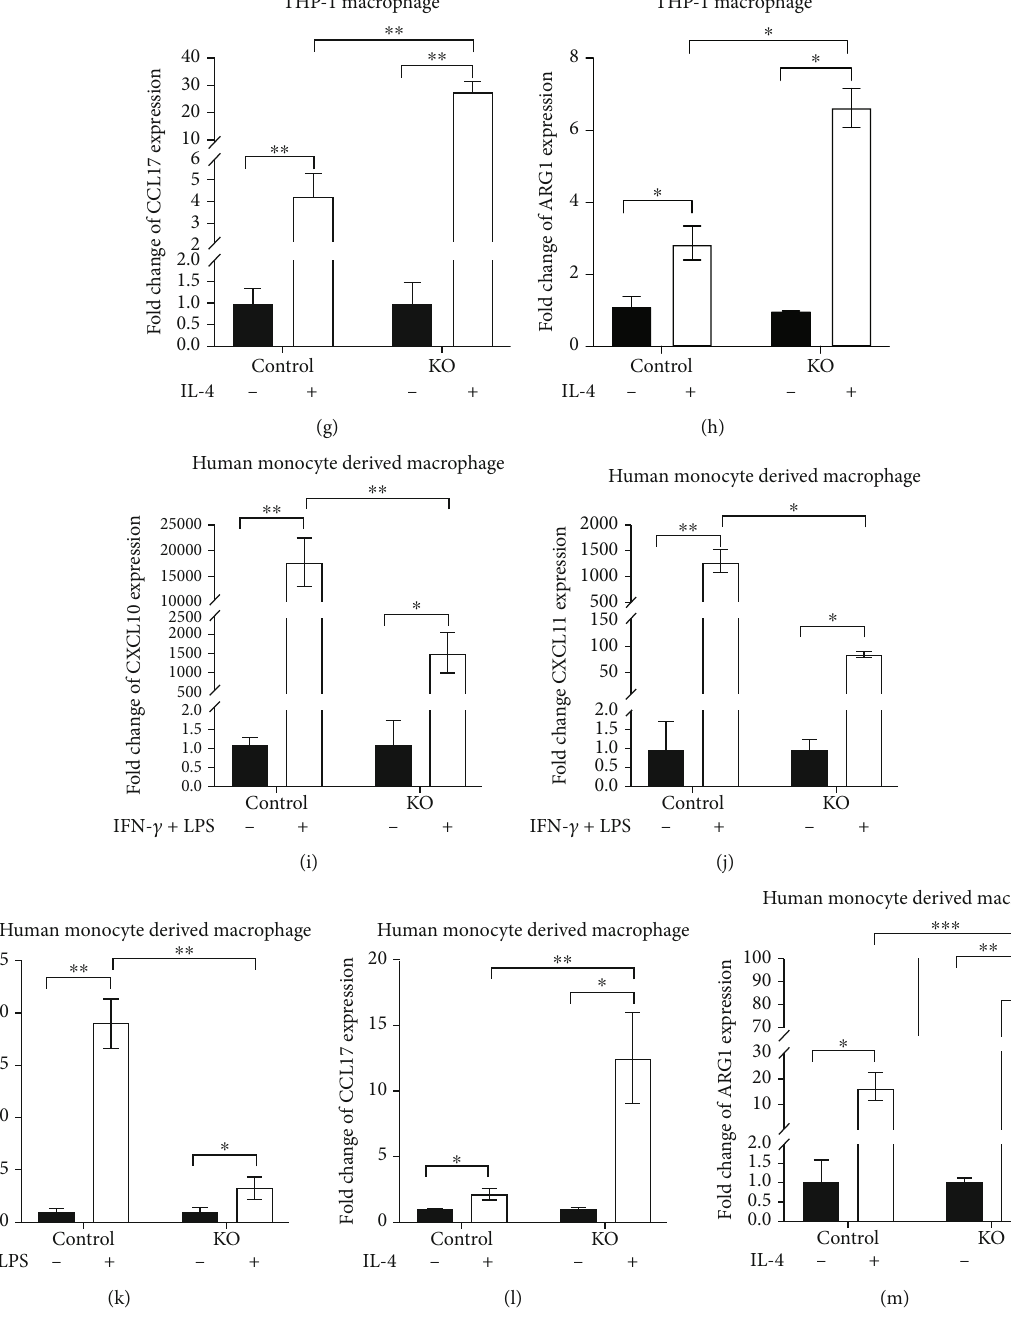
Figure 4: Knockout of lnc-MRGPRF-6:1 inhibits the formation of M1 macrophage and reduces the secretion of in fl ammatory cytokines. (a – c, i – k) The mRNA level of CXCL10, CXCL11, and IL-1 β in M1-type macrophage was detected by RT-qPCR. (g, h, l, m) The expression of CCL17 and ARG1 in M2-type macrophage. (d, e) The protein levels of TNF- α and TNF- β in M1-type macrophage were detected by ELISA. (f) The expression of IL-10 in M2-type macrophage. ns: not statistically signi fi cant; ∗ P < 0 : 05 , ∗∗ P < 0 : 01 , ∗∗∗ P < 0 : 001 , and ∗∗∗∗ P < 0 : 0001